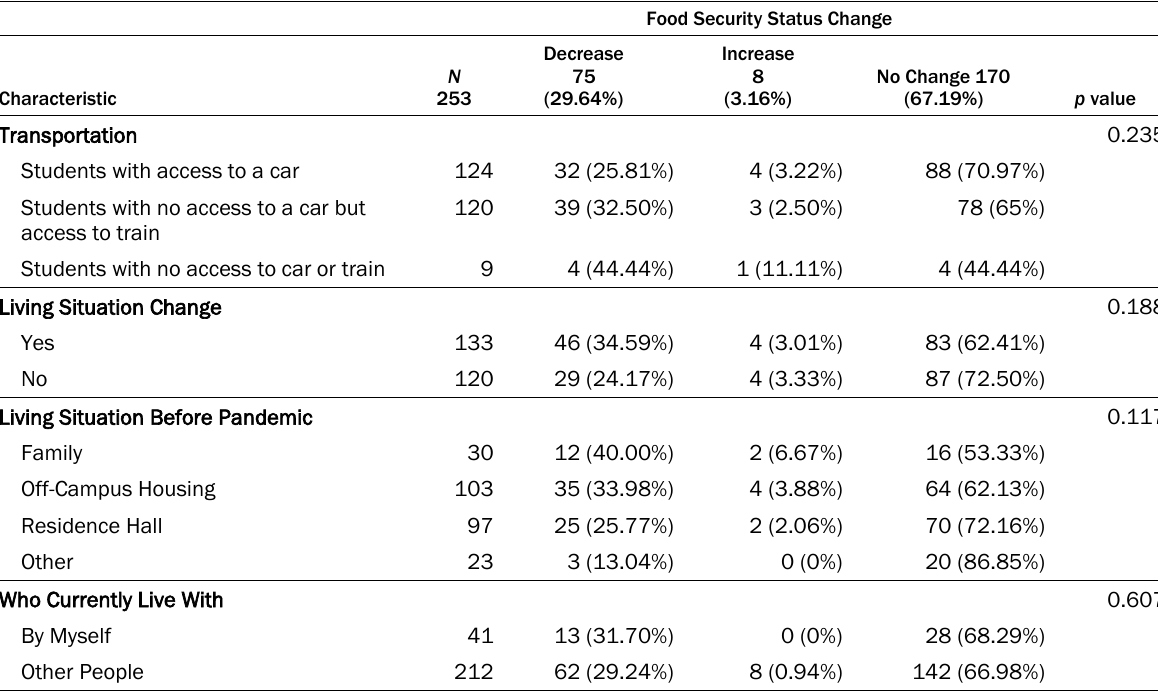
Table 4. Results of Fisher Exact Test for Food Security Status Change and Food Access